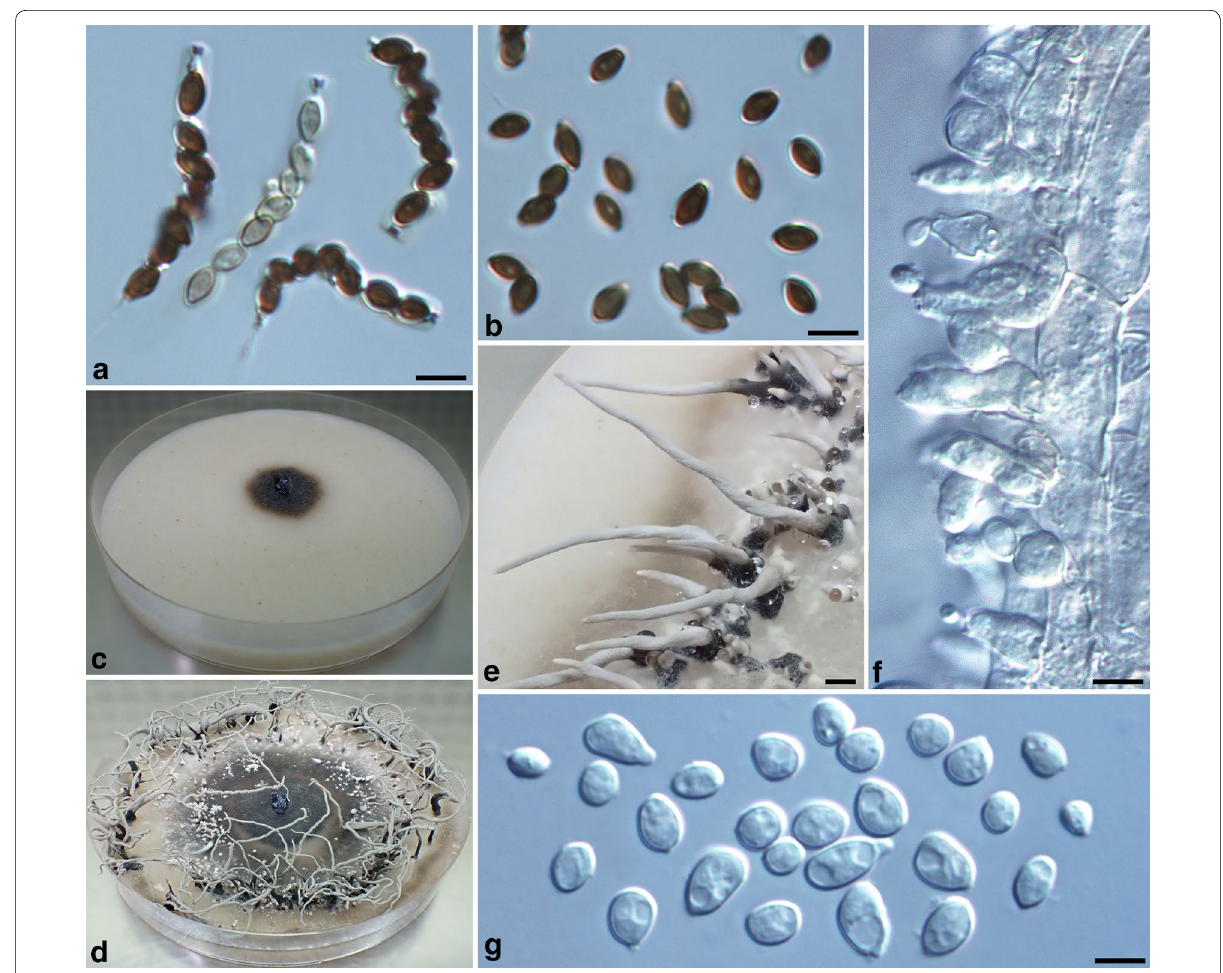
Fig. 6 Xylaria subescharoidea (from the holotype). a Ascal apical rings and ascospores. b Ascospores with a half of these showing a pore‑like germination site. c , d Colony on 9‑cm Petri plate containing OA at 1.5 week and 3 week, respectively. e Stromata produced in culture. f Conidiophores. g Conidia. Bars in a , b , f , g 5 μm; e 2 = =